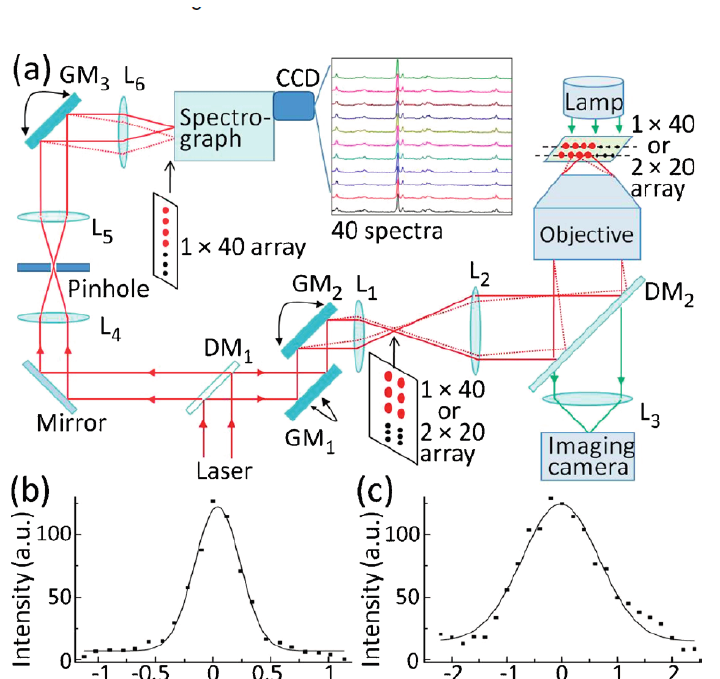
Figure 8. ( a ) Schematic of a multifoci-scan confocal Raman imaging system; ( b ) Lateral; and ( c ) axial intensity profiles of the Raman band at 1001 cm − 1 of a 100 nm diameter polystyrene bead [57] (With permission from AIP Publishing